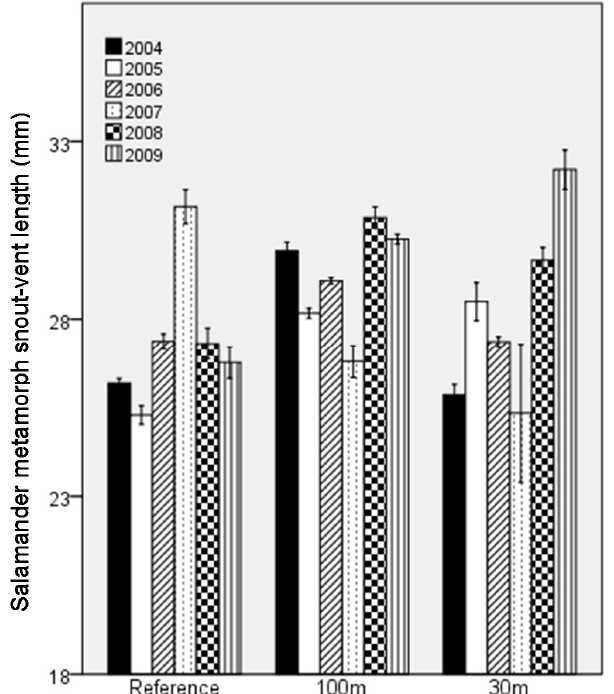
Figure 4. Mean (±1 SE) spotted salamander metamorph snout ‐ vent length, across 3 experimental forestry treatments and 6 study years at 11 natural ephemeral pools in east ‐ central Maine, USA. Treatments were: reference (uncut), 100 m undisturbed buffer, and 30 m undisturbed buffer.